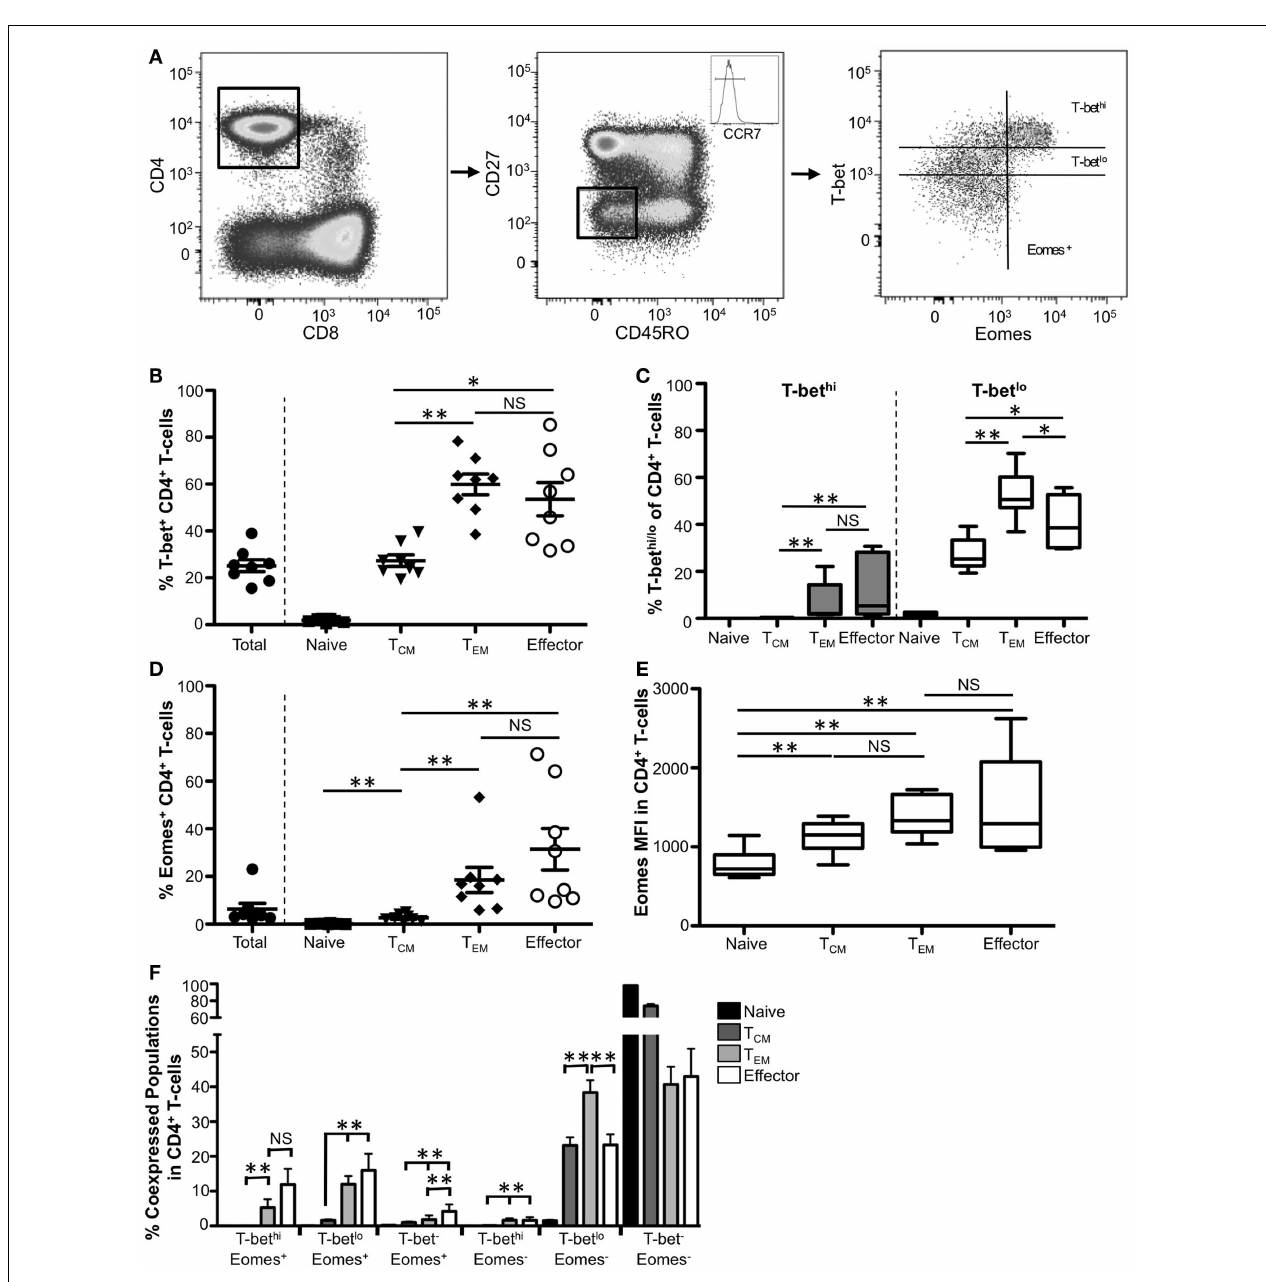
(CD27 − CD45RO − CCR7 − ) cells is shown. Each symbol represents an individual donor. (C) Graphical representation of the mean frequency of T-bet hi (gray) andT-bet lo (white) CD4 + T-cells is shown for each subset.The box and whisker graphs display 25–75% (box) and 10–90% (whisker).The line in the box represents the median value. (D) The frequency of CD4 + T-cells expressing Eomes is shown for each subset. (E) Median fluorescence intensity (MFI) is shown for Eomes within each subpopulation. (F) Co-expression ofT-bet and Eomes within each memory subset is shown. * p < 0.04, ** p <